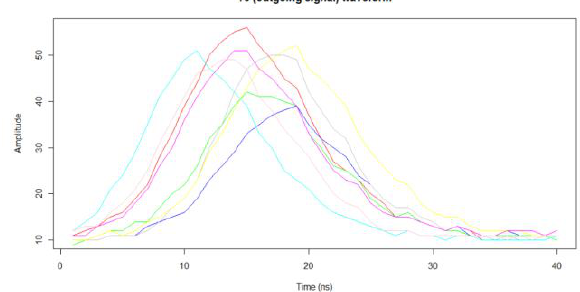
Figure 2. Plot of eight waveforms of the outgoing